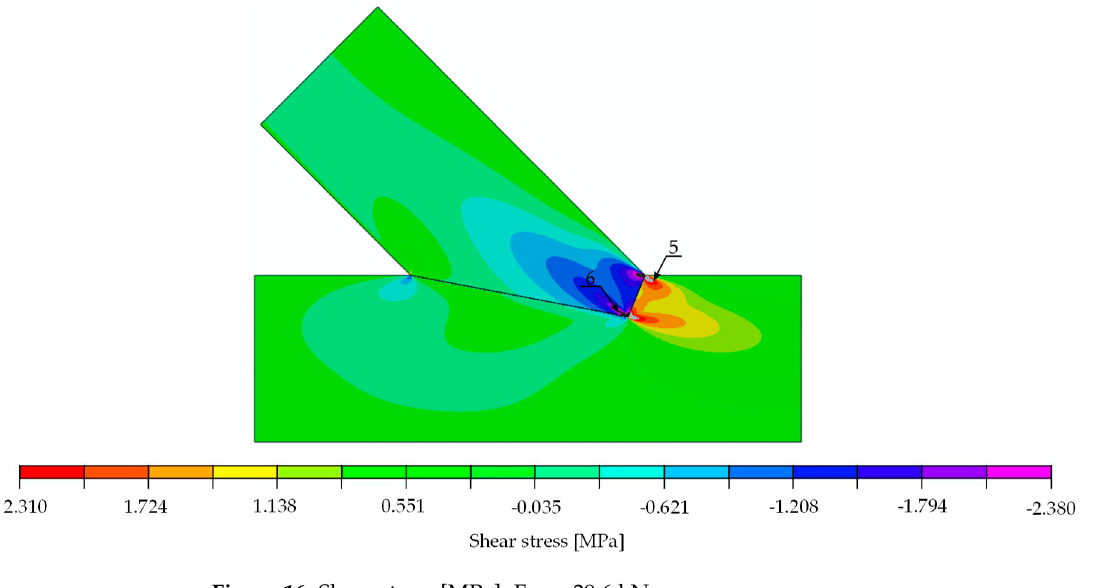
Figure 16. Shear stress [MPa]. Force 29.6 kN.